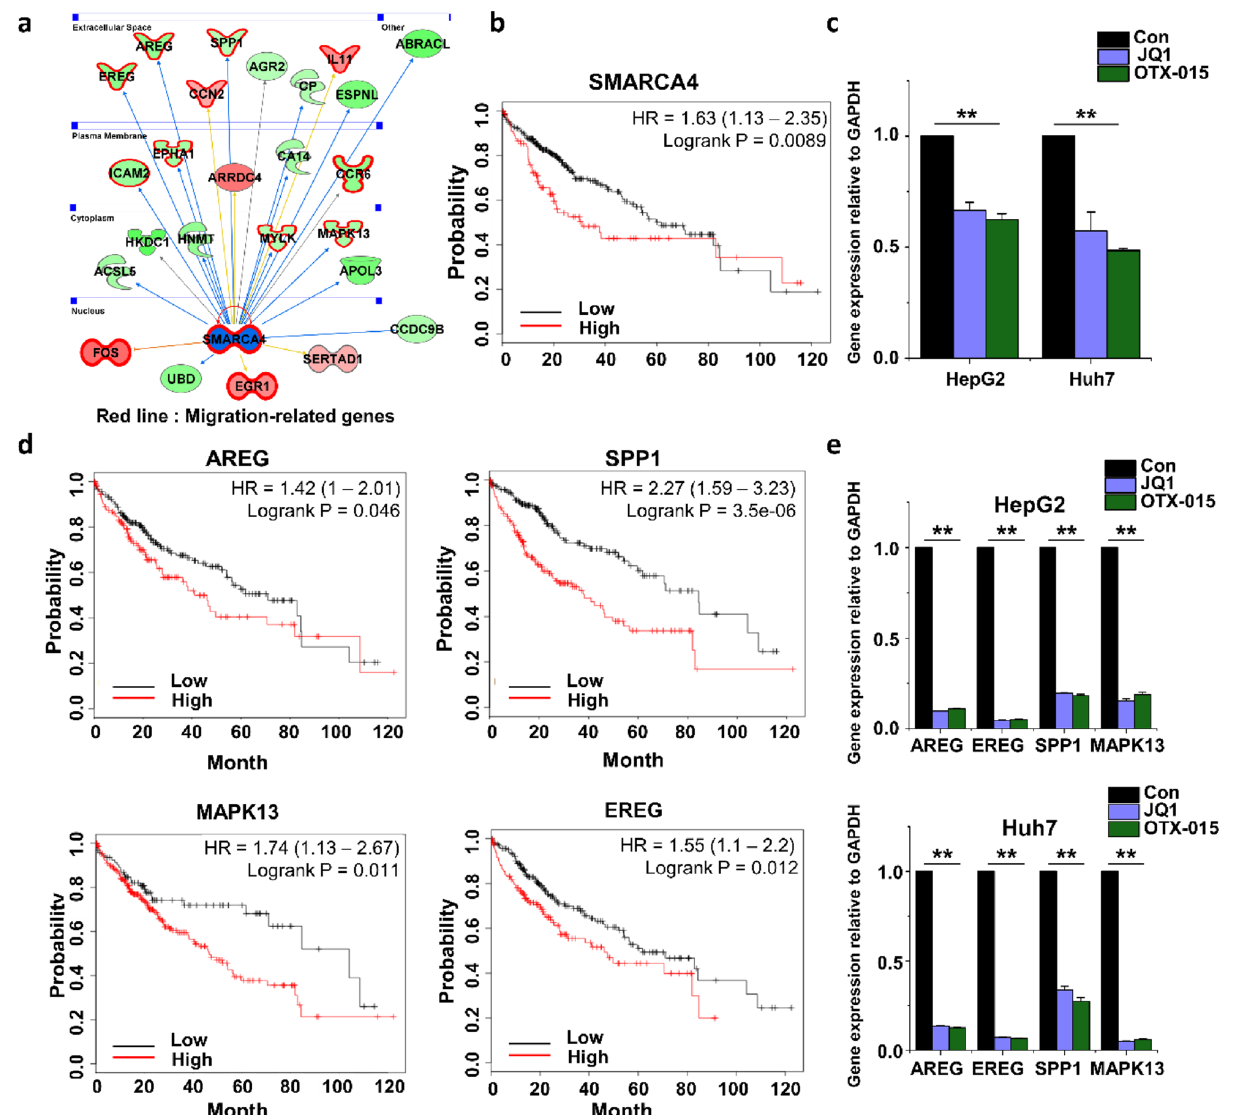
Figure 5. Differences in the expression of migration-related genes. ( a ) Migration response molecules were analyzed with an IPA molecule activity predictor. Shown are the migration response molecules regulated by SMARCA4. The red line indicates migration-related genes. ( b ) Kaplan–Meier plotter analysis for overall survival of HCC patients was divided into high and low SMARCA4 expression groups. The result indicated that patients with low SMARCA4 expression had a better prognosis than those with high SMARCA4 expression. ( c ) Confirmation of SMARCA4 expression levels in JQ1- or OTX-015-treated HCC cells. ( d ) Kaplan–Meier